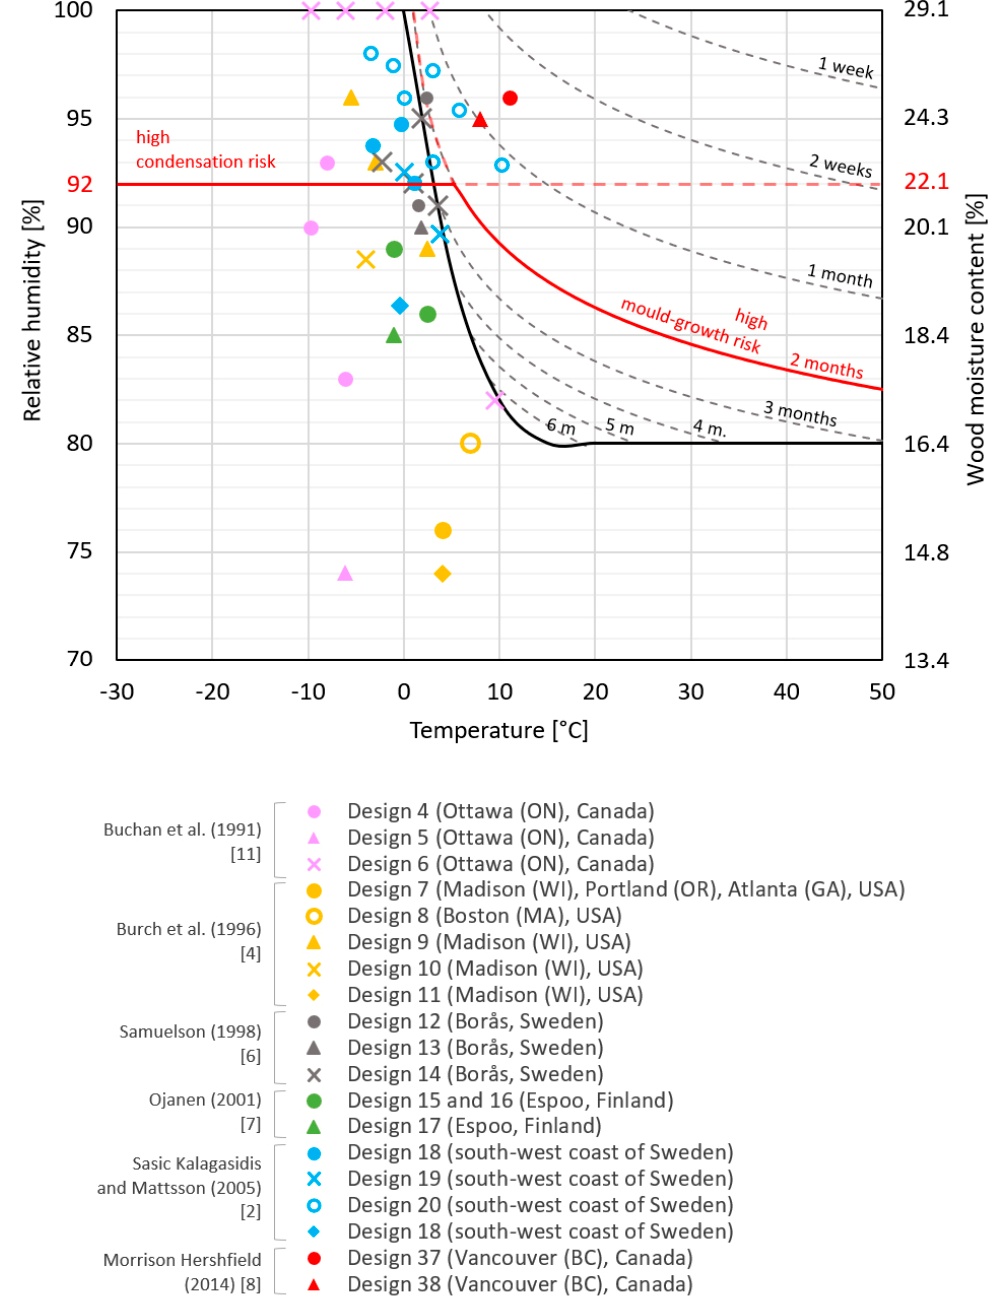
Figure 6. Moisture-risk chart (monthly averages of the worst moisture–temperature conditions within the attic).